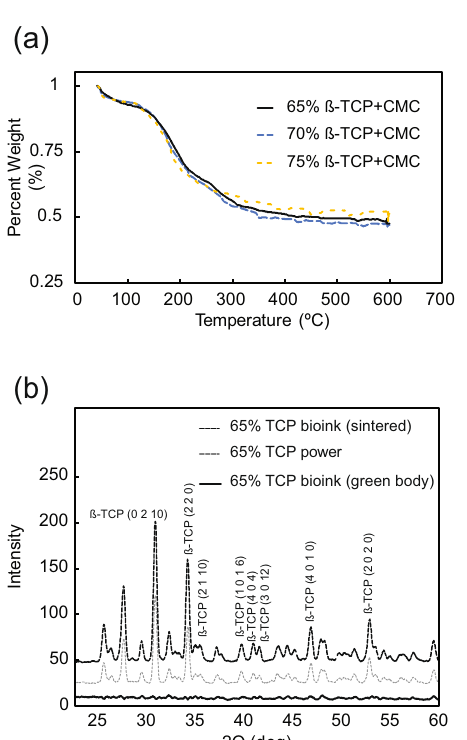
Fig. 3 Mechanical properties of the new formulations of the ceramic bioinks after sintering. The ultimate strength ( a ) and modulus ( b ) of the 75% ß-TCP plus 3% CMC composition were highest among the formulations tested. (* p < 0.05). CMC